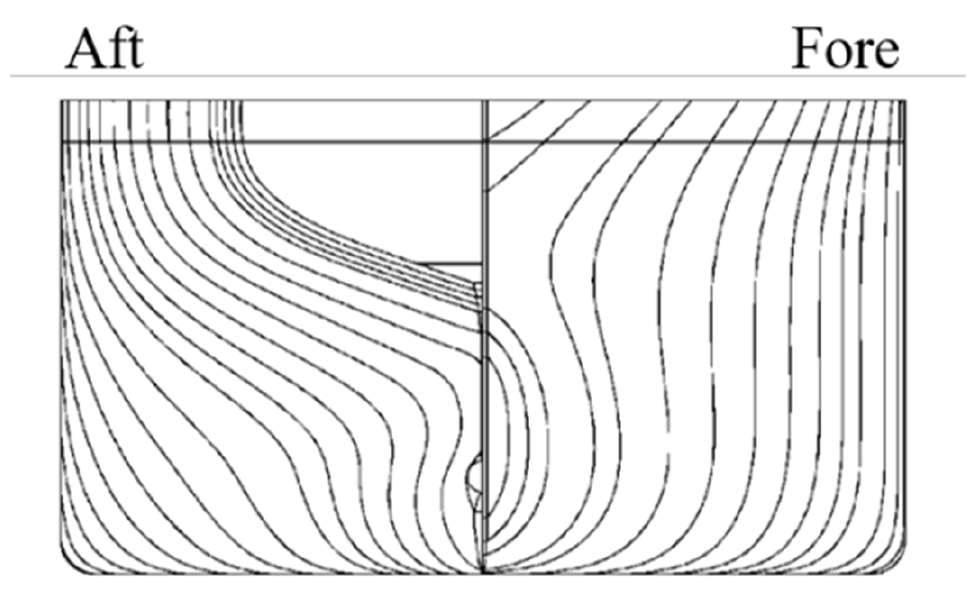
Figure 1. Bodyplan of a JBC. Table 1. Principle dimensions of a JBC.